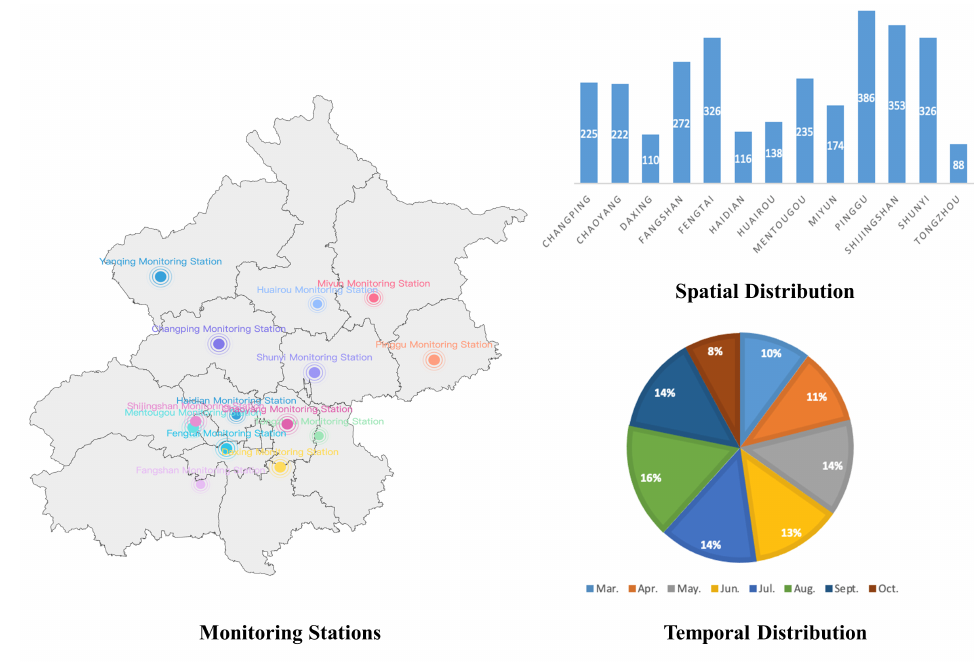
Figure 4. Statistics of monitoring stations, spatial distribution, and temporal distribution in our dataset.